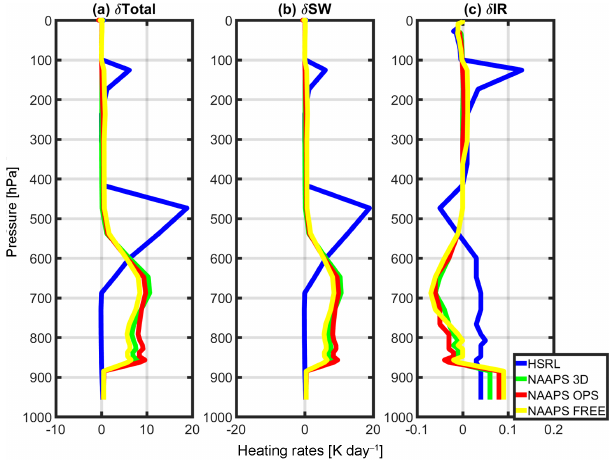
Figure 8. Instantaneous heating rate differences ( δ( IHR ) = NOAER-AER) between all four aerosol profiles (AER = HSRL, NAAPS OPS, NAAPS 3-D, and NAAPS FREE) and the control run (NOAER) using MAIAC 555µm (BRF = 0.5152). The different panels depict (a) the net instanta- neous heating rates ( δ IHR TOT ), (b) , the SW Total instantaneous heating rates ( δ IHR SW ), and (c) IR instantaneous heating rates ( δ IHR IR